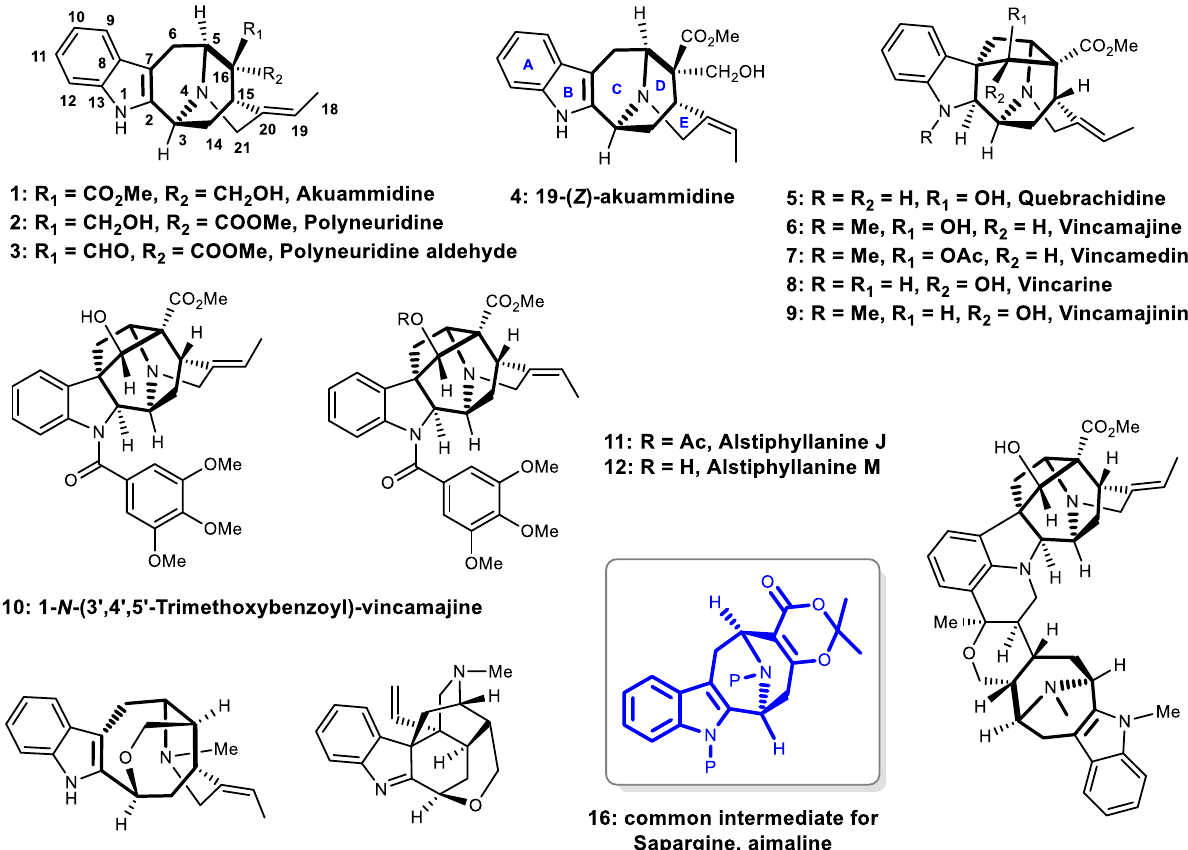
Fig. 1 Some representative sarpagine-ajmaline-koumine type alkaloids. In this work, alkaloids 1 – 9 , 11 , 13 , and 14 are